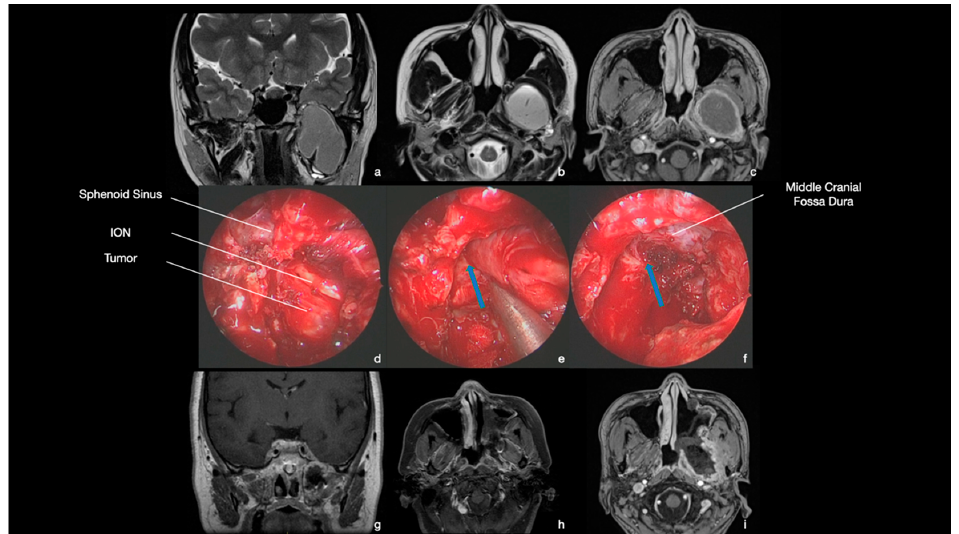
Figure 7. MRI and intraoperative endoscopic images (0° scope). ( a – c ) MRI. Coronal and axial T2 w-sequence and T1 w-sequence with contrast agent. A large tumor was observed in the left PPF and ITF. ( d ) Intra-operative image. After medial maxillectomy, the posterior wall of the maxillary sinus is removed, and the tumor is exposed. The mass was of firm consistency and diffusely bleeding. ( e ) Intra-operative image. Tumor was progressively resected, and the mandibular nerve was identified and anatomically preserved until the foramen ovale (blue arrow). The mass was cleaved from middle cranial fossa dura, without any CSF leak. ( f ) Intra-operative image. At the end of the surgery, the tumor was radically removed, with preservation of anatomical structures. ( g – i ) MRI. Coronal and axial T1 w-sequence with contrast agent. Complete tumor removal was demonstrated.